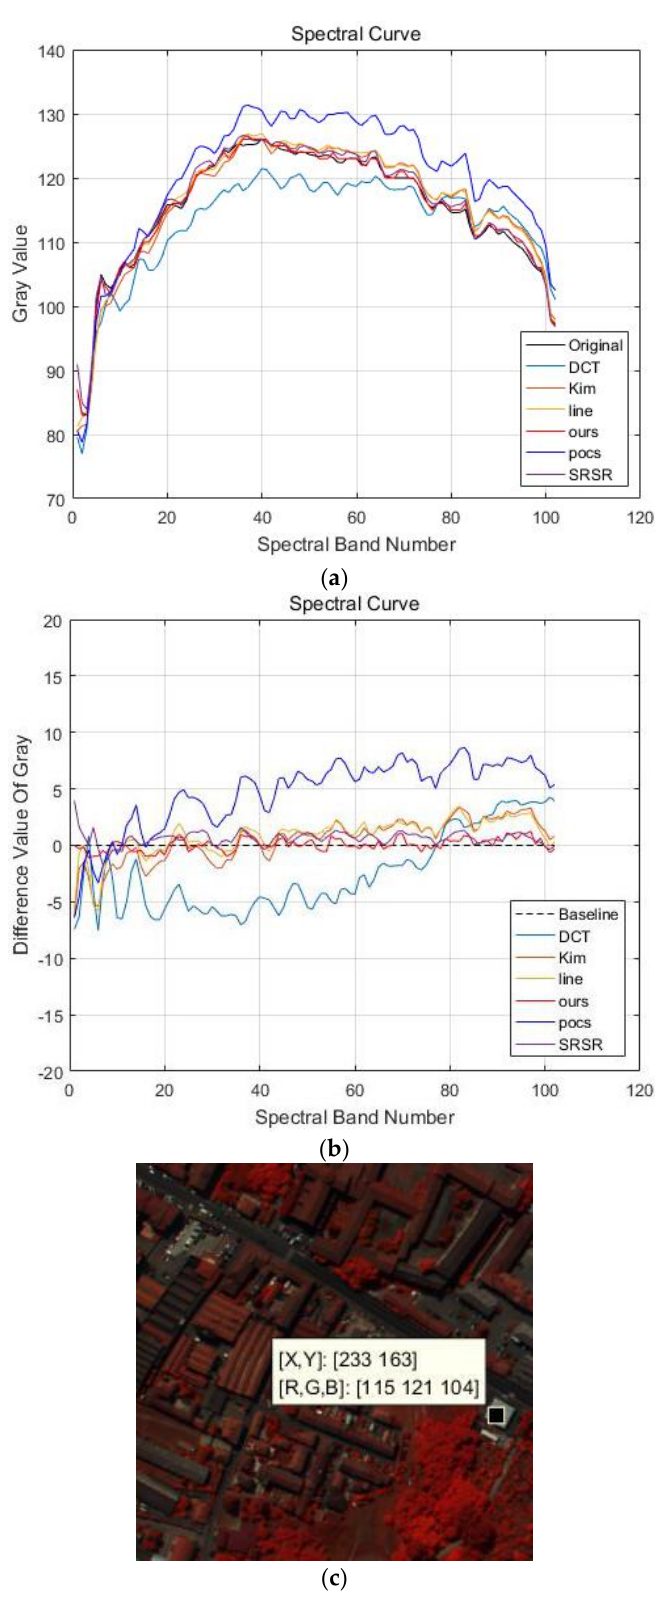
Figure 7. Spectral curves of pixel (233,163) in the PaviaC dataset. ( a ) Spectral curves of different methods; ( b ) Difference values of spectral curves (the black dotted line is the baseline, the red line illustrates the results of the proposed methods); ( c ) spectral curve location.